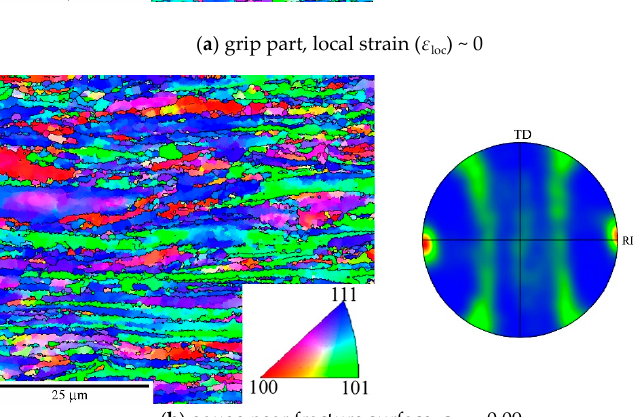
Figure 8. Microstructure and texture of RS after creep at σ 0 = 200 MPa in ( a ) grip part and ( b ) gauge length near the fracture. RD directions are parallel with the stress axis.